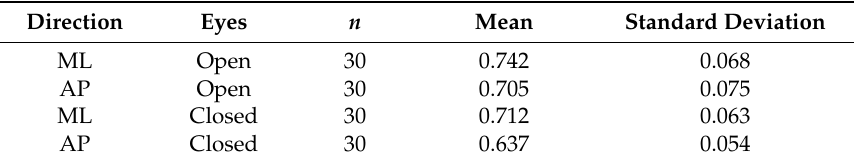
Table 3. Comparison of ApEn values for quiet standing with and without visual feedback.